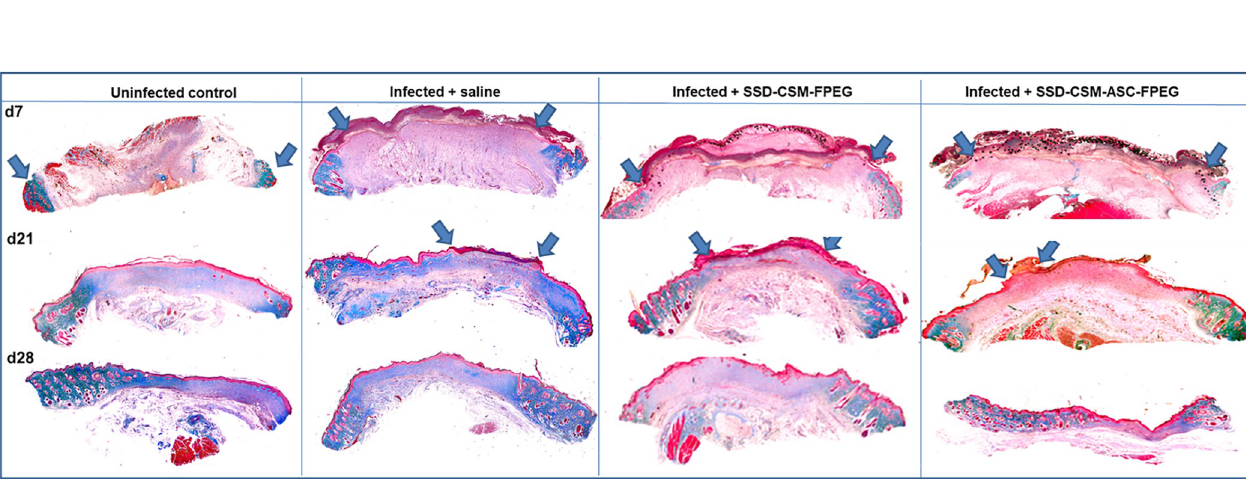
PLOS ONE | https://doi.org/10.1371/journal.pone.0217965 June 13,